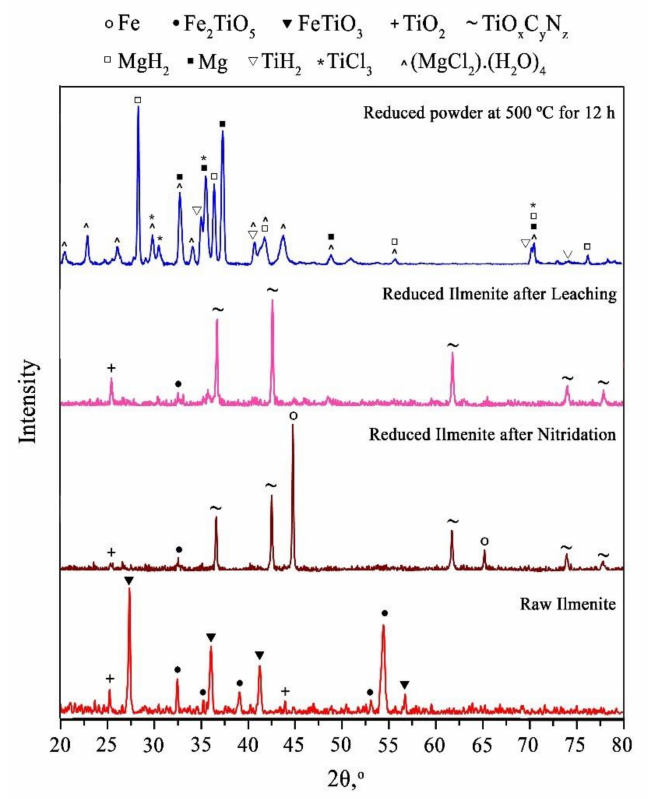
Figure 7. XRD analysis data for raw ilmenite, nitrided ilmenite before and after Becher process, and reduction process of TiCl 4 with MgH 2 at 500 ◦ C for 12